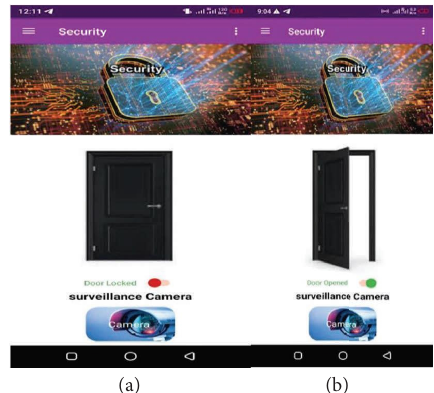
Figure 11: (a) Use the app to close the door; (b) use the app to open the